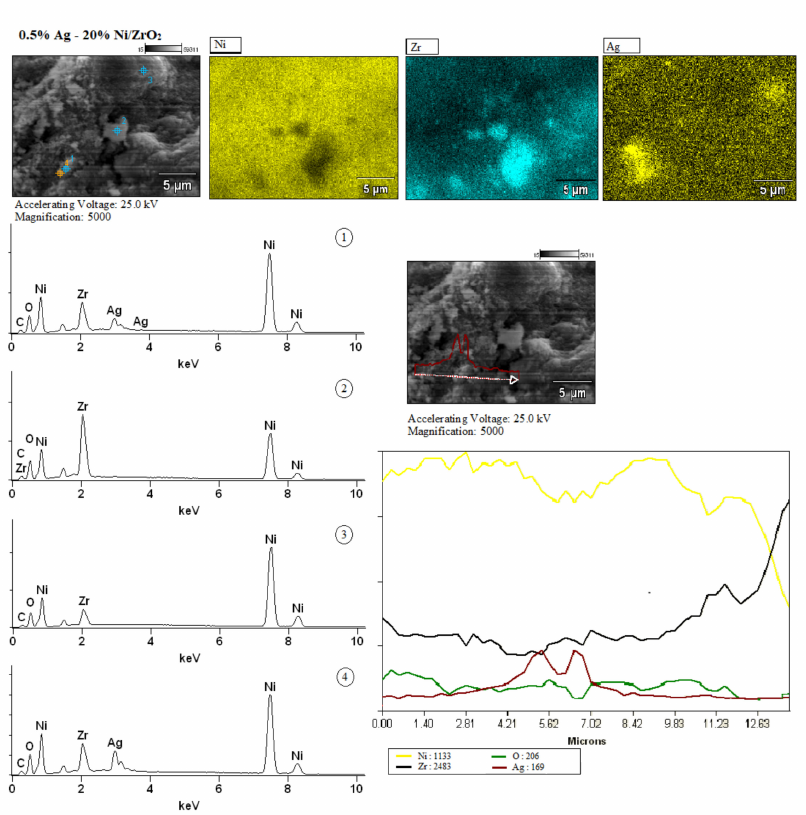
Figure 13. SEM images, EDS spectra collected from the marked points and line analysis recorded for bimetallic 0.5% Ag-20% Ni / ZrO 2